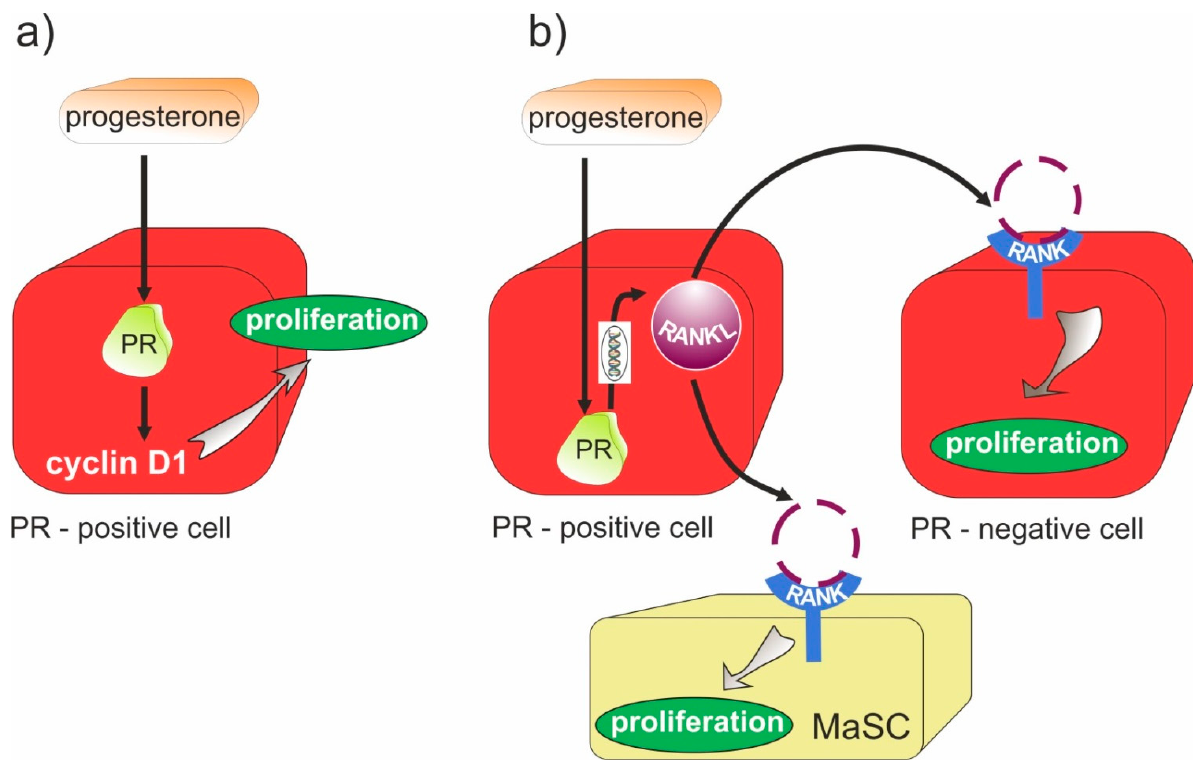
Figure 1. Progesterone (P4)/progesterone receptor (PR) signaling and RANK/RANKL pathway in cells proliferation. ( a ) autocrine mechanism mediated by the activation of cyclin D1 in cells. ( b ) Paracrine cell proliferation. Up-regulation of RANKL by P4 action in PR-positive cells causes RANK/RANKL complex expression in PR-negative cells; therefore, the RANK-NF- κ B proliferative pathway is stimulated. Moreover, RANK/RANKL expression in mammary stem cells (MaSCs) activates their expansion.